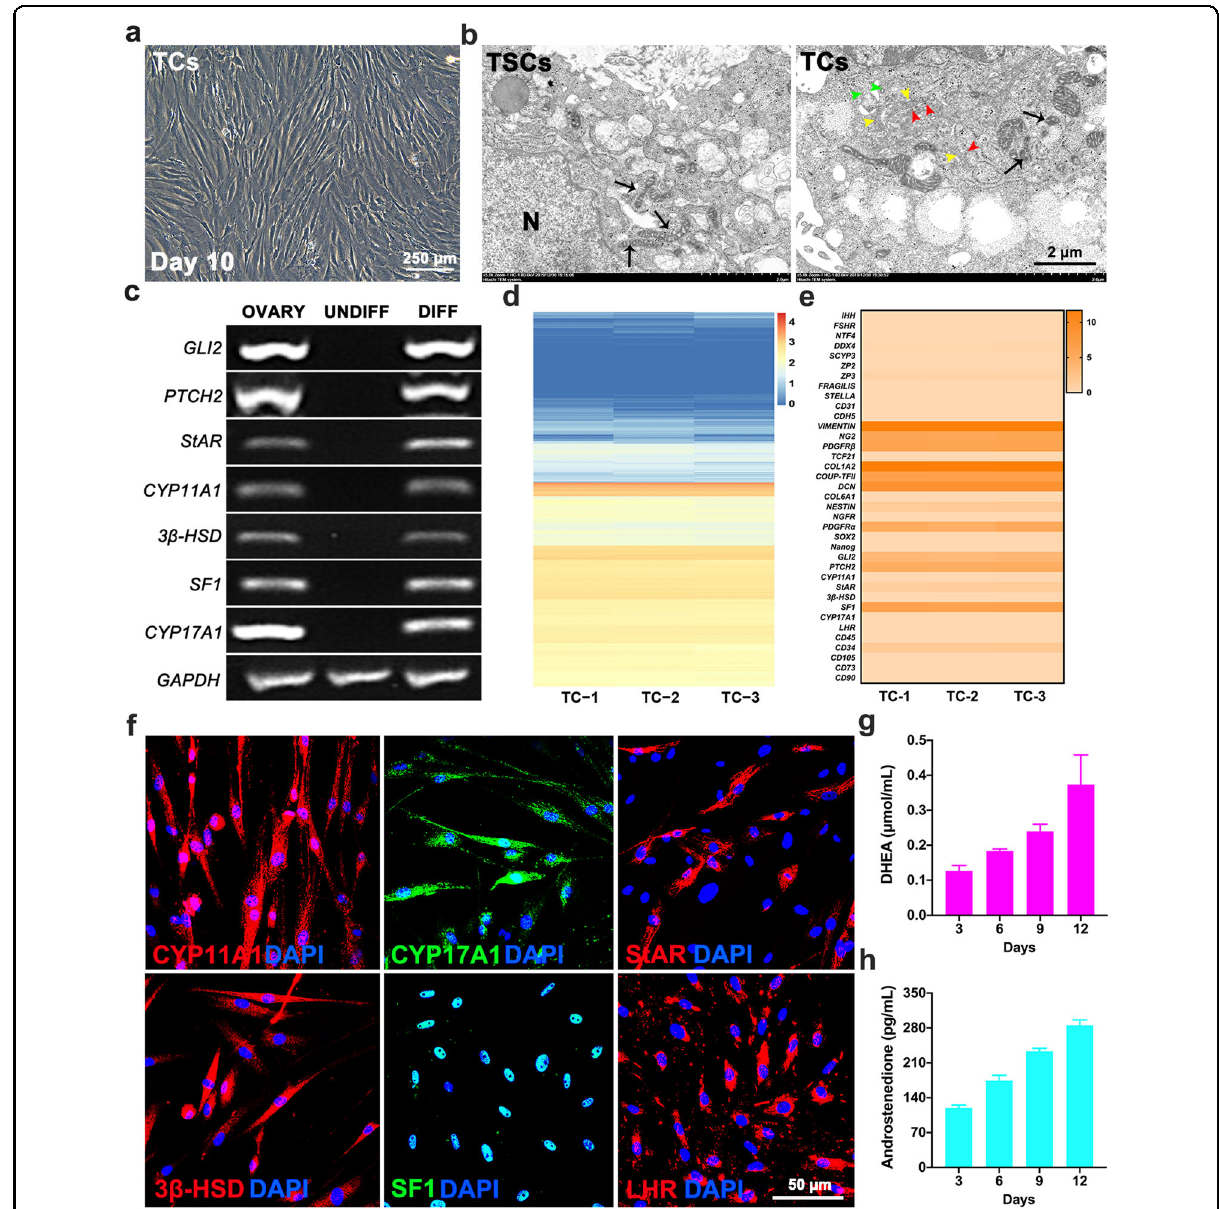
Fig. 2 Multilineage differentiation capacity of TSCs in vitro. a Phase-contrast micrographs of TSCs after 10 days of differentiation. b The TSCs and TCs organelles were observed under electron microscope. mitochondria with lamellae or typical tubular cristae (black arrow), smooth ER (red arrow), Golgi apparatuses (yellow arrow), vacuoles (green arrow), N nucleus. c RT-PCR analysis con fi rmed that the expression of the TCs lineage-speci fi c markers was increased in differentiated cells (DIFF) compared with undifferentiated controls (UNDIFF), in which the markers were undetectable. d Heatmap showed expression of gene for the TCs ( n = 3). e Heatmap showed expression of marker genes for the major cell types in the TCs ( n = 3). f After differentiation for 12 days, immuno fl uorescence staining showed that the TSCs clearly expressed the TCs lineage-speci fi c markers, CYP11A1, CYP17A1, StAR, 3 β -HSD, SF-1, and LHR. g Dehydroepiandrosterone production progressively increased during culture in differentiation-inducing time. h Androstenedione production progressively increased during culture in differentiation-inducing time ( n =